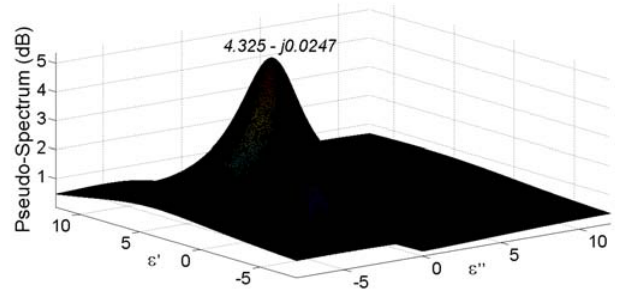
Figure 4: Pseudo-spectrum of FR-4 sample at 801 frequencies, frequency range 4.0 GHz and thickness 30 mm.